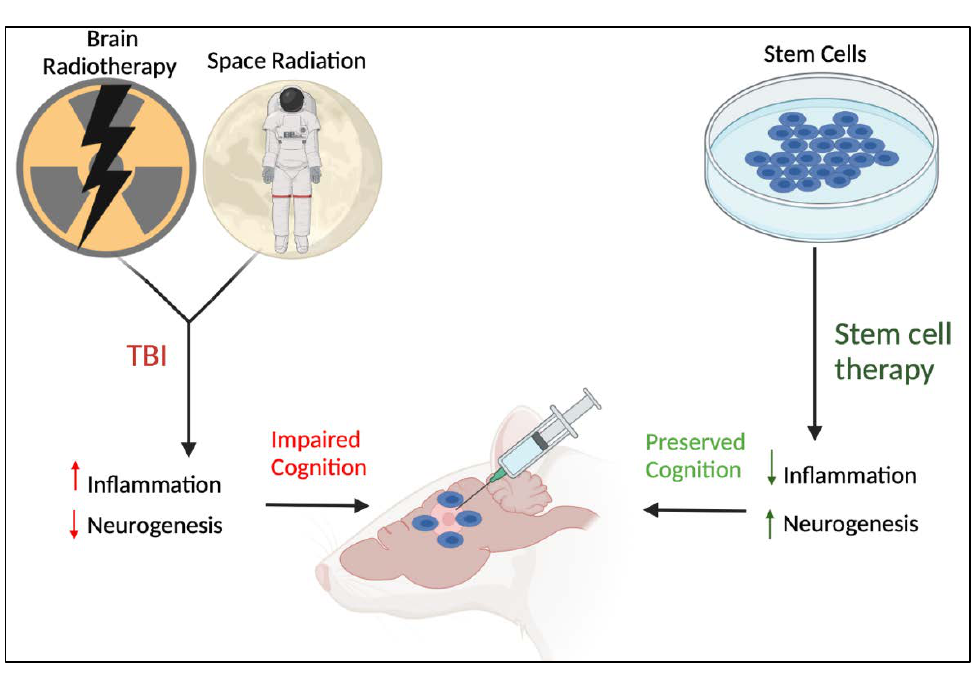
Figure 3. Compelling evidence suggests that brain radiotherapy and space radiation produce TBI- like pathology characterized by aberrant deleterious inflammation and dysfunctional neurogenesis resulting in impaired cognition. Stem cell-based therapies can sequester inflammation and enhance stem cell proliferation in the TBI animals, leading to preserved cognition. Figure constructed via Biorender.com.